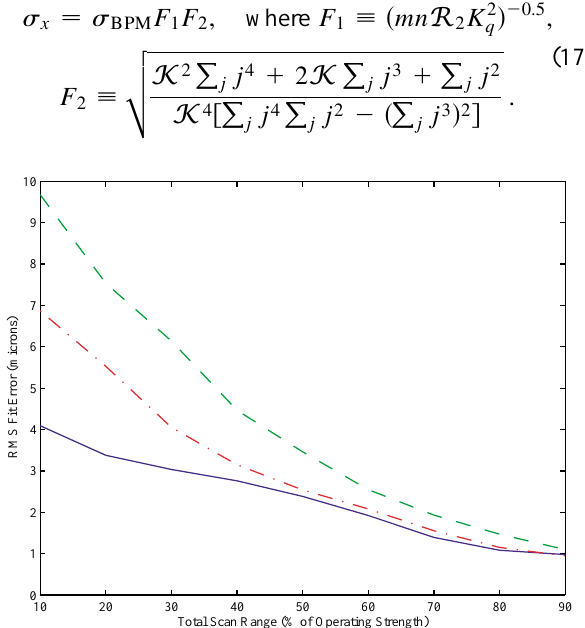
FIG. 6. (Color) rms alignment fit error due to permeability mismatch as a function of maximum strength excursion. In this case, five values of the quad strength are used, and the quad is stepped monotonically towards zero strength. Curves shown are for a design strength which is 70% (blue solid line), 80% (red dot-dashed line), or 90% (green dashed line) of the maximum strength of the quad.